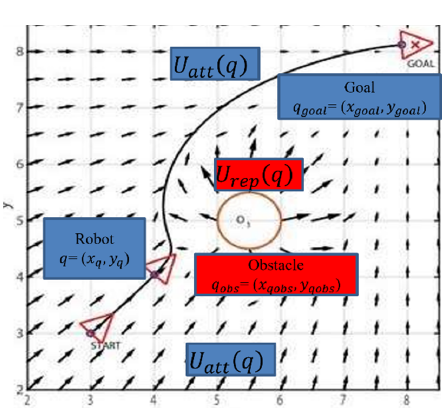
Figure 7. Attractive and repulsive potential field [30].